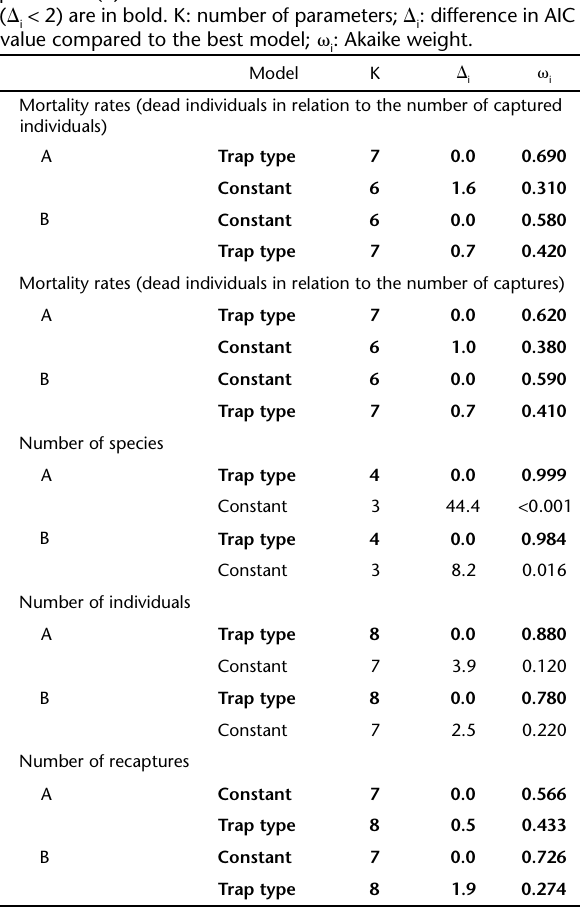
Table 2. Results of model selection for mortality rates, and for the number of species, of individuals and of recaptures of small mammals as a function of the type of trap. Two data-subsets were used for Sherman traps: only captures from Sherman placed adjacent to pitfall lines (A) or from Sherman traps intercalated with pitfall lines (B). Check the text for random factors. Selected